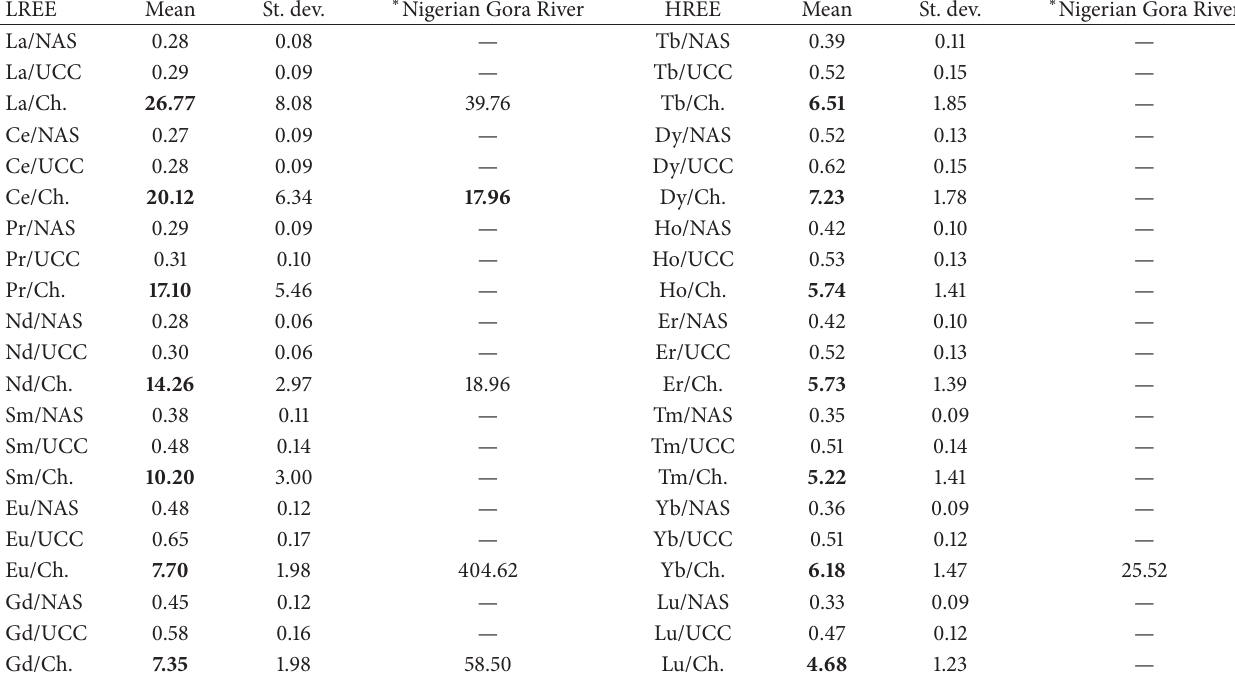
Table 3: REE concentrations in river water in ppb. The Amazon, Indus, Mississippi, and Ohio Rivers data from Goldstein and Jacobsen [13]. LREE 𝑁 =